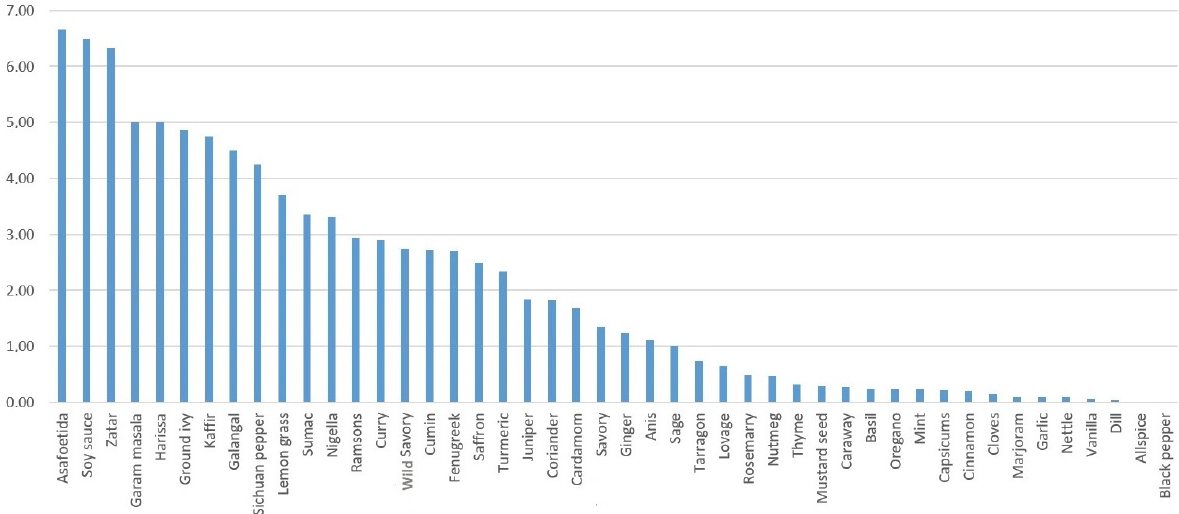
Figure 1. Spices and spice mixes aligned according to the Index of Change (IC), from the most novel in use to those already used 10 years ago.